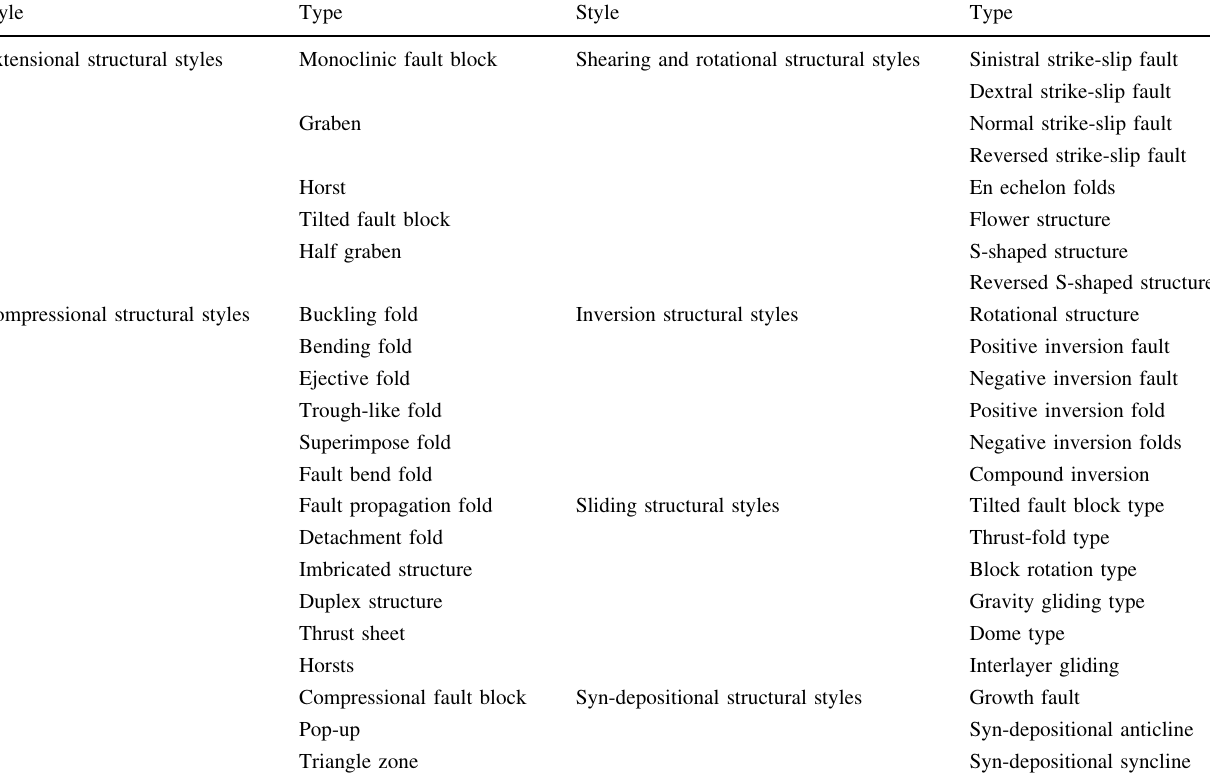
Table 5 Coal-controlling structural